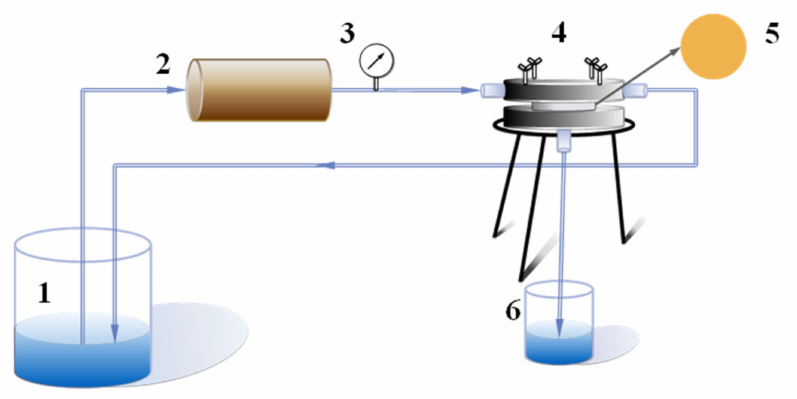
Figure 1. Schematic diagram of cross-flow experimental device: 1. Feed liquid; 2. Peristaltic pump; 3. Pressure gauge; 4. Membrane assembly; 5. Measured film; 6. Penetrating